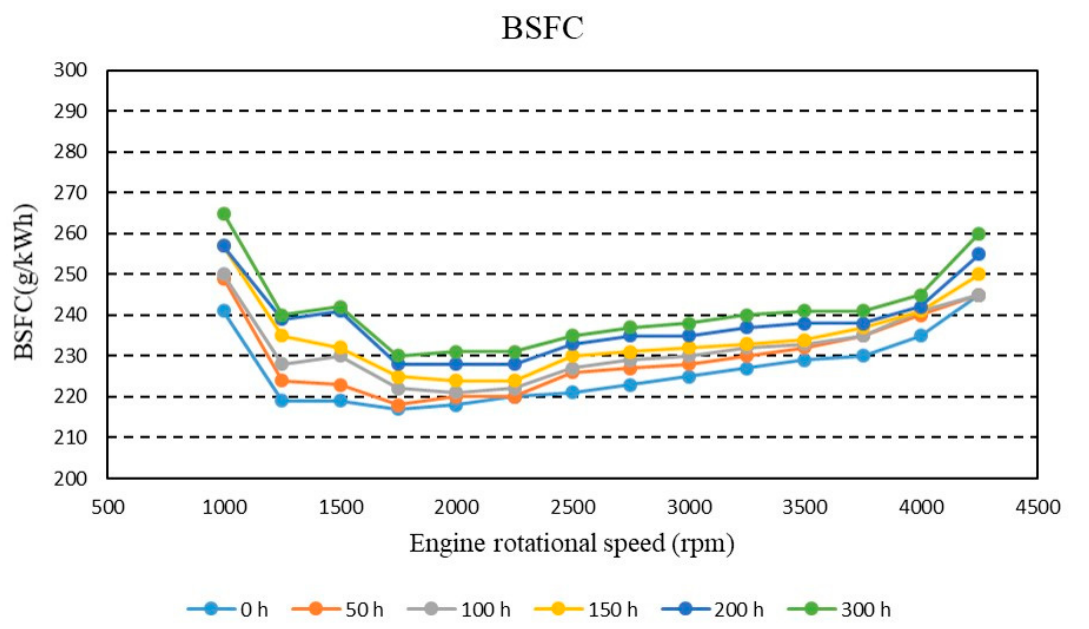
Figure 16. Changes in the engine BSFC during the 300 h durability test.